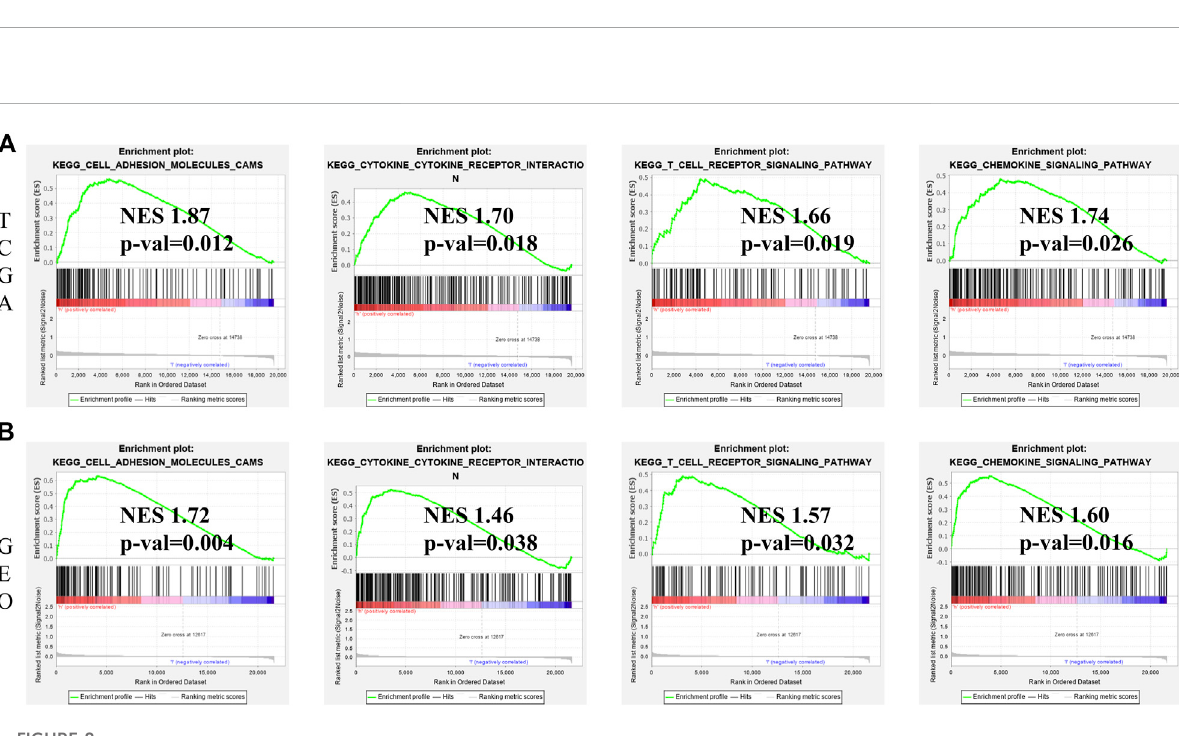
FIGURE 8 GSEA for identi fi cation of ferroptosis-associated signaling pathways. (A) GSEA of related signaling pathways in the high-risk group in TCGA cohort. (B) GSEA of related signaling pathways in the high-risk group in GEO